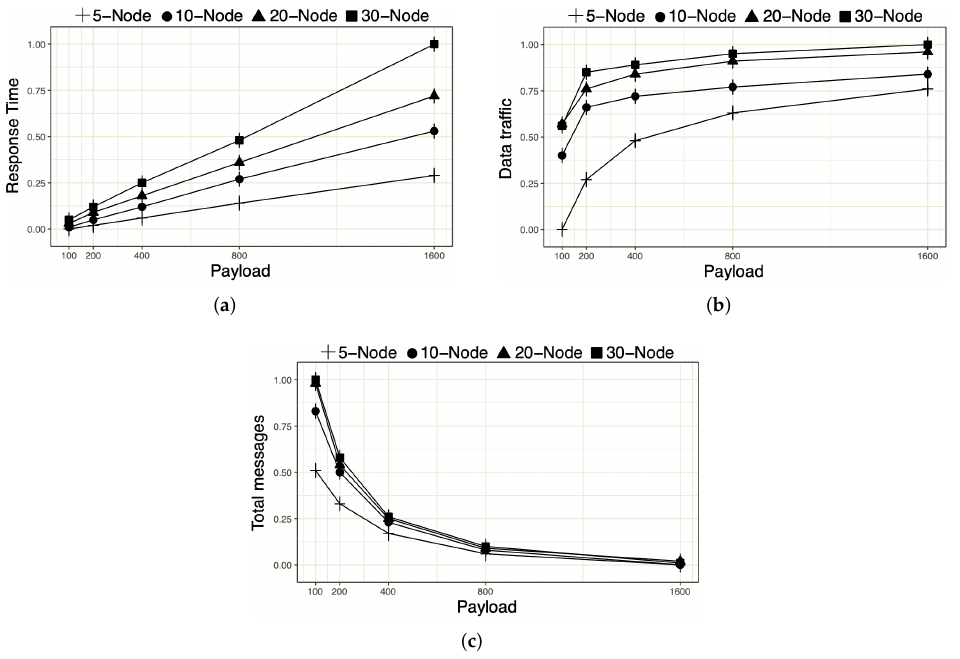
Figure 4. The impact of response time, data rate and message delivery. ( a ) Response Time; ( b ) Data traffic; ( c ) Message delivery